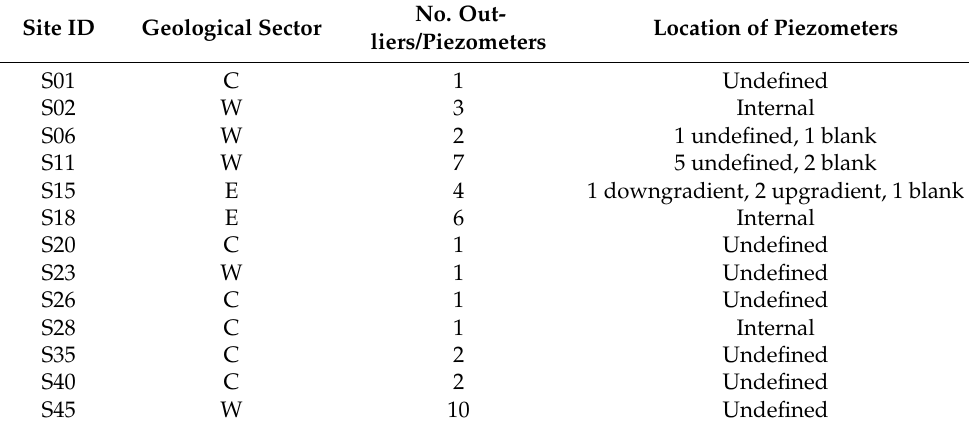
Table 3. Summary of the spatial As